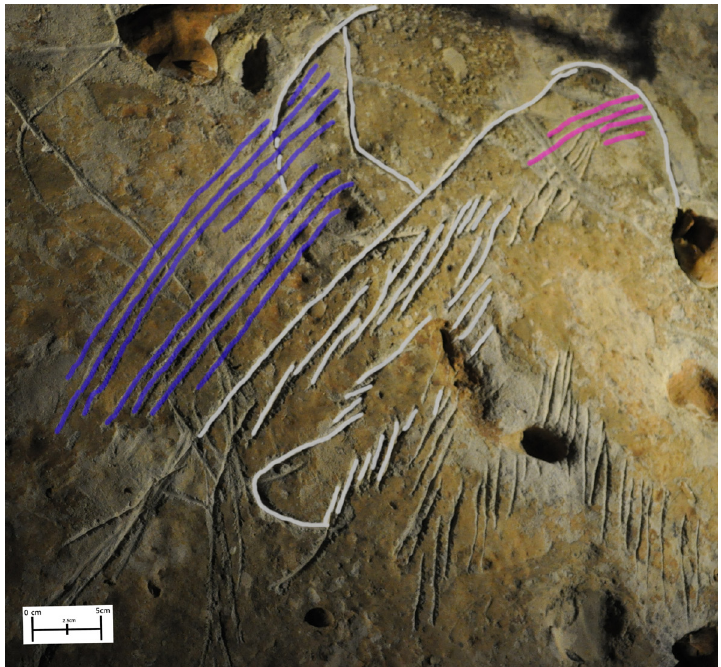
Figure 4. Fluting in Rouffignac made by the male adult (blue) and a female adult (pink) which intersect figurative images (high- lighted in grey for